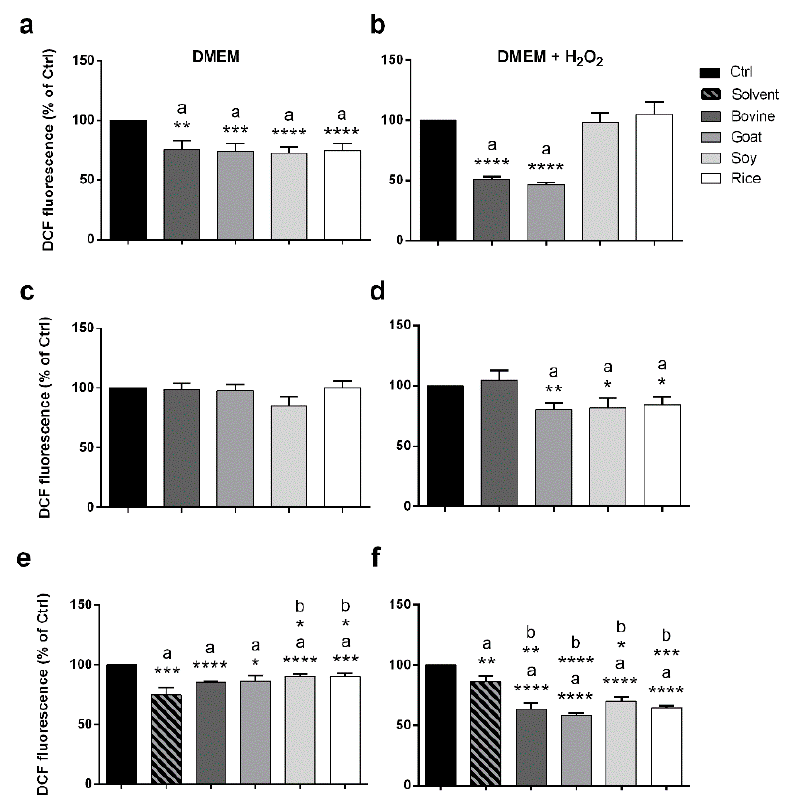
Figure 5. Antioxidant ability of raw milks and their total and free lipid fractions as assessed by a DCF assay. The bars represent the mean value of DCF fluorescence intensity relative to the Ctrl ± SEM ( n = 3) of Caco-2 cells treated with raw milks ( a , b ) and their total and free lipid fractions (25 µ g/mL, ( c , d ) and ( e , f ), respectively) before ( a , c , e , respectively) and after ( b , d , f , respectively) H 2 O 2 stimulation. Ctrl: crude milks: only cells; total and free lipid fractions from crude milks: DMSO. a : sample vs. Ctrl; b : sample vs. solvent. * p < 0.05, ** p < 0.01, *** p < 0.001, **** p <